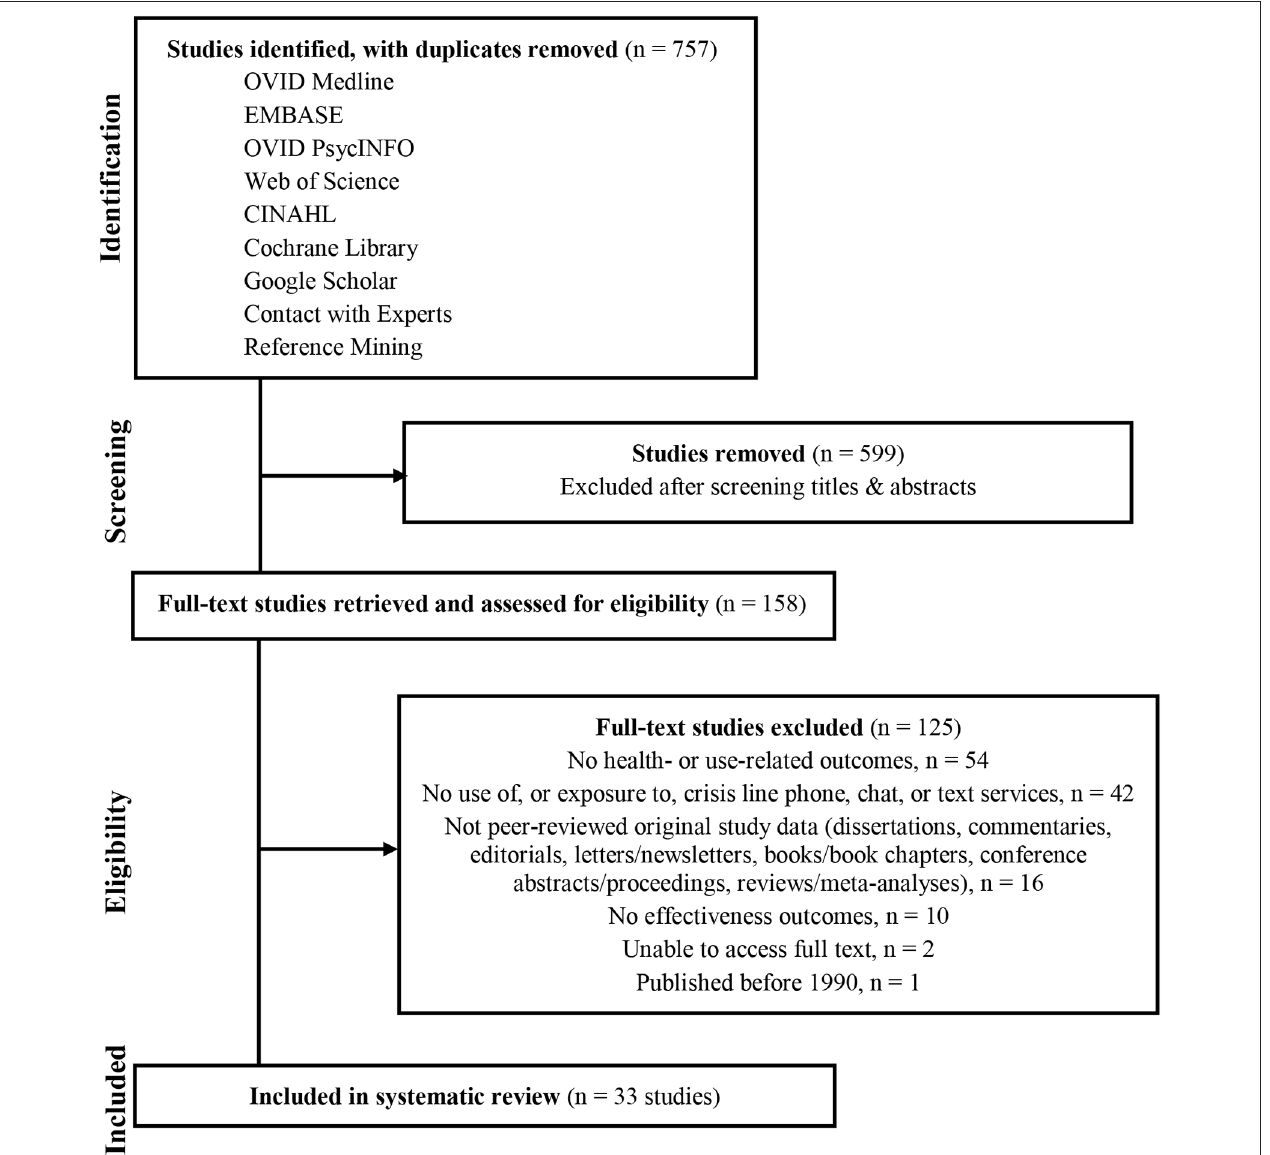
FIGURE 1 | PRISMA literature flow